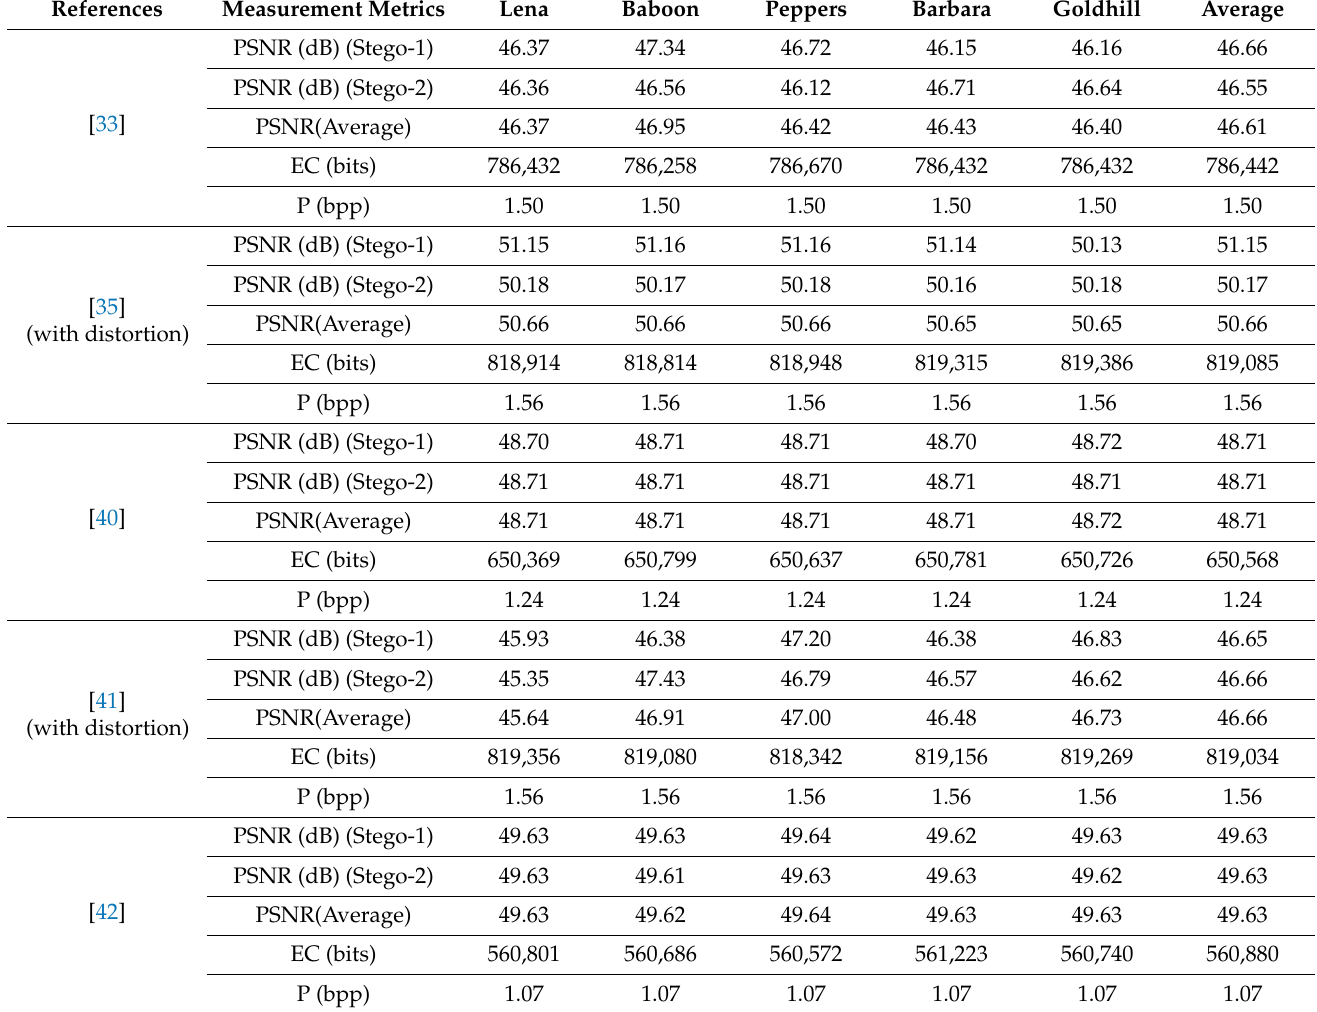
Table 10. Comparison of previous data hiding algorithm and the proposed